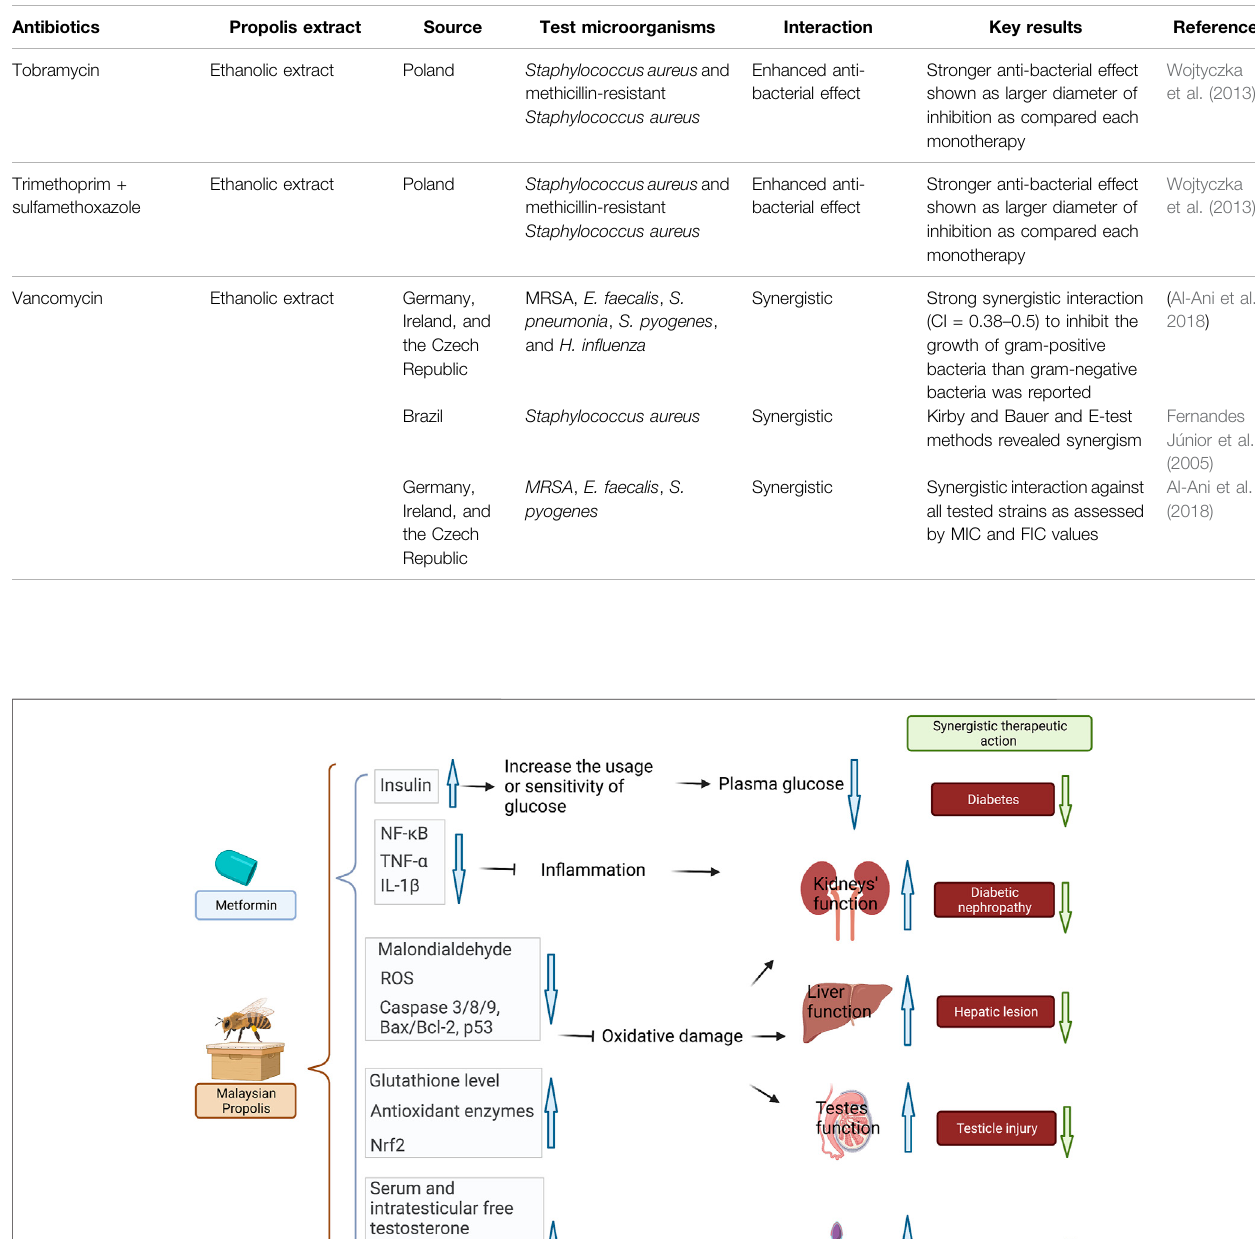
Frontiers in Pharmacology |